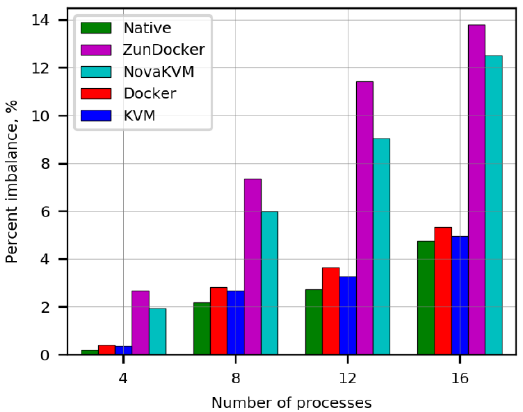
Figure 10. Load imbalance measured on the native hardware and the OpenStack cloud.